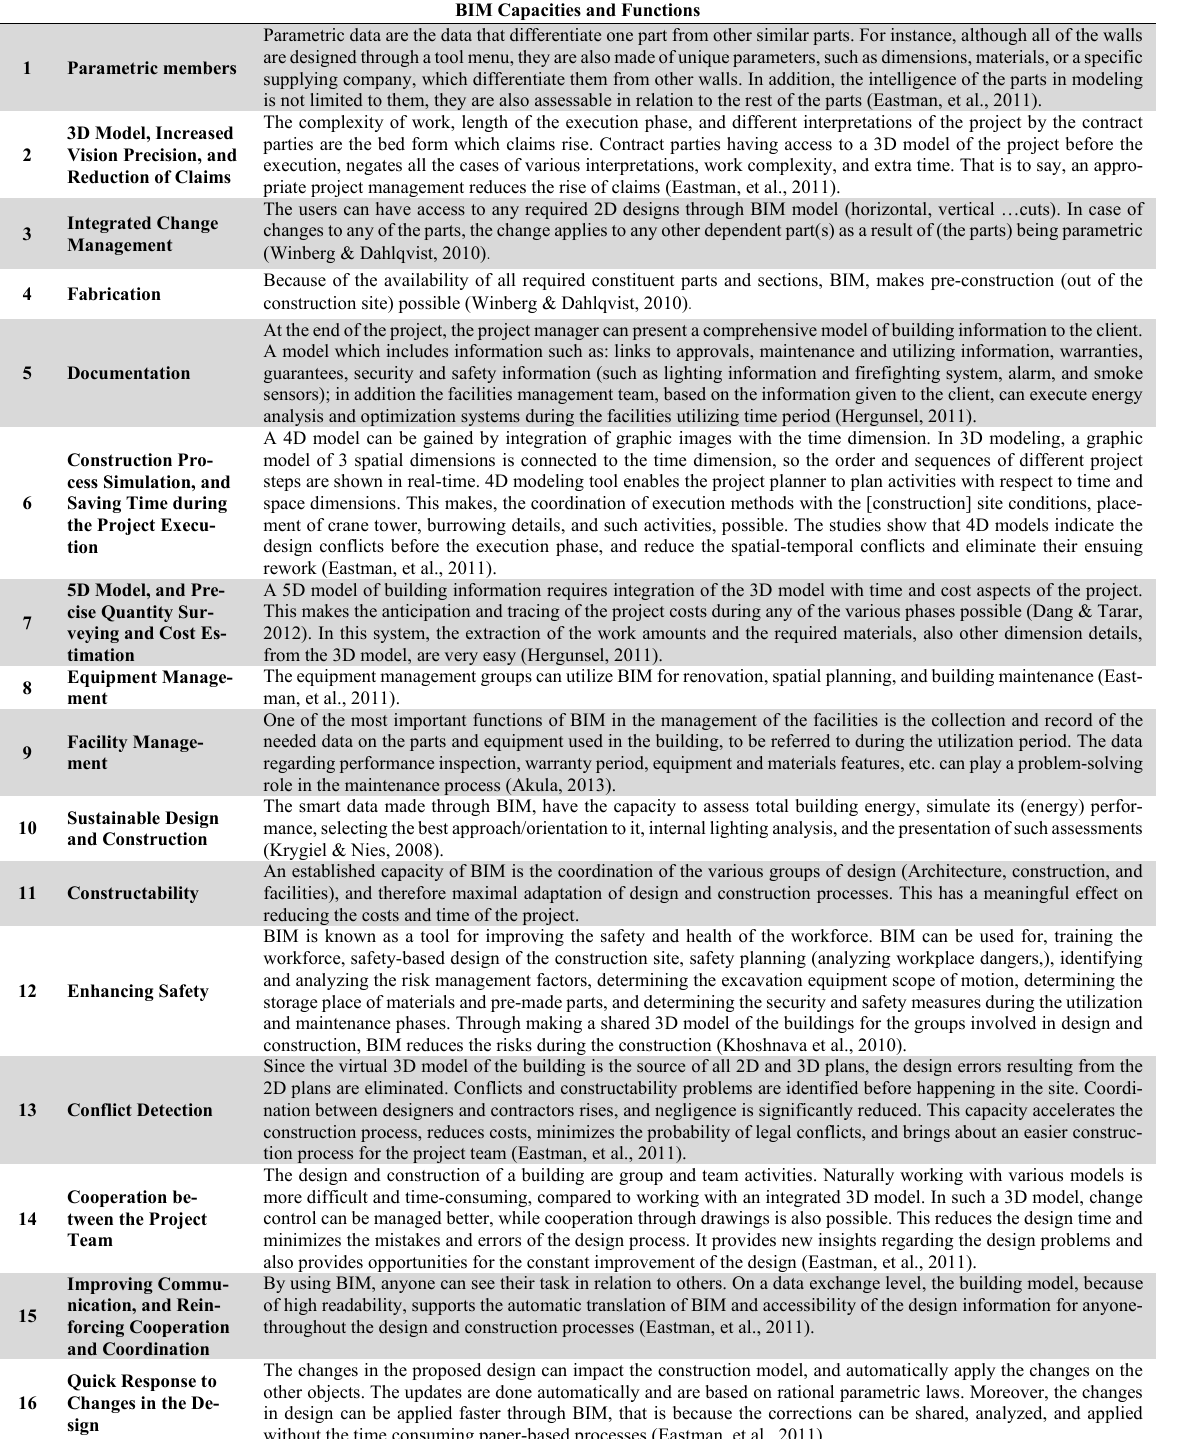
BIM Capacities and